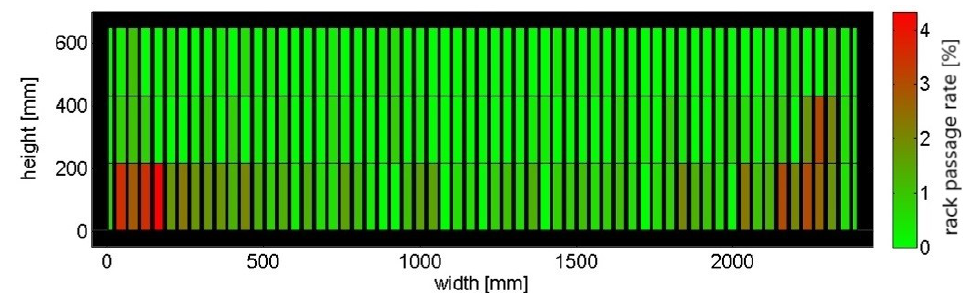
Figure 7. Location of rack passages [%] between bars (X-axis: distance from left side (mm)) and for three height levels (Y-axis: close to channel bed, middle and close to the water surface or distance from bottom (mm)) over all performed experiments in all setups (N = 20; n = 1100; n passages,all =